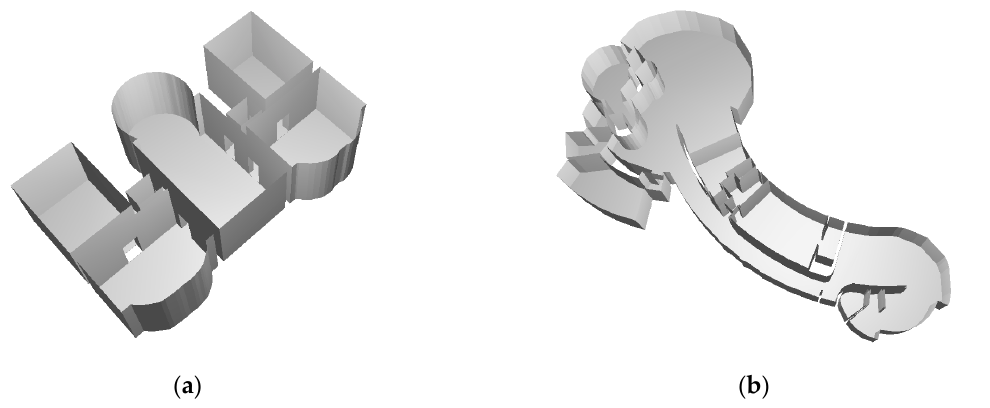
Figure 14. ( a ) Generated 3D indoor model for dataset-1; and ( b ) generated 3D indoor model for dataset-2. The ceilings are removed for clarity.